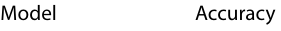
Table 6 Obtained results for ORIGA dataset using various methods and variations represented in